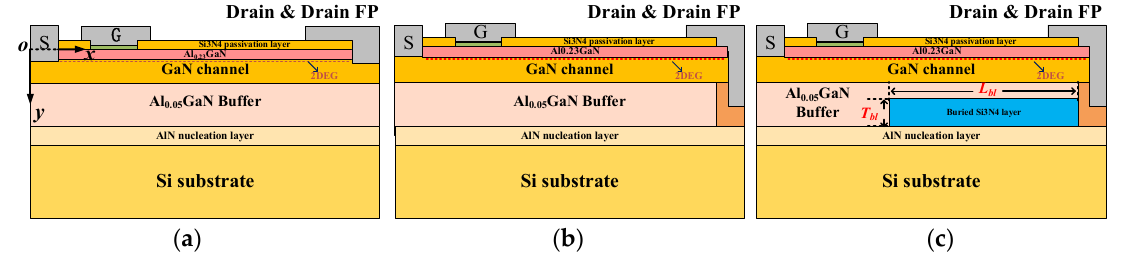
Figure 1. Schematic cross-section of the ( a ) Con-HEMT, ( b ) DC-HEMT, and ( c ) proposed buried Si 3 N 4 passivation layer GaN HEMT (BP-HEMT).